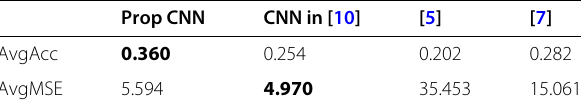
The performance are compared with [10] and with the